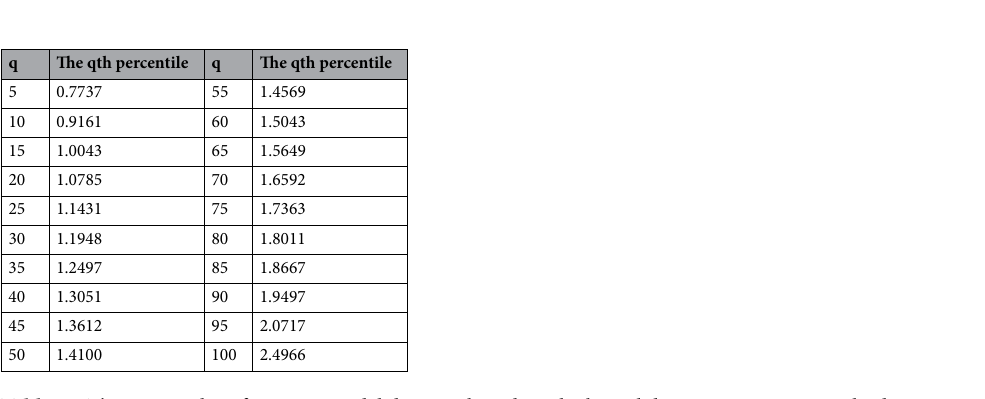
Table 4. The percentiles of Kimura model distance based on the kernel density estimation